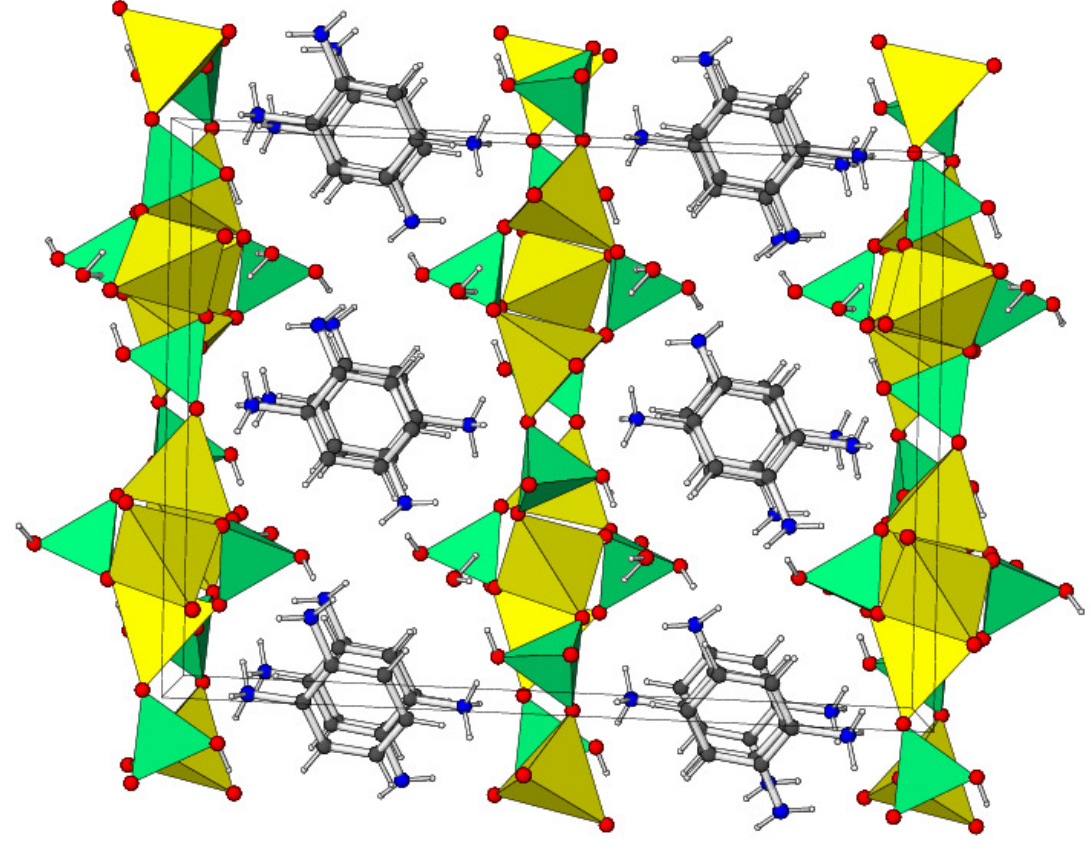
HPO moieties as yellow and green tetrahedra, respectively. Atom colors: O red; N blue; 4 C dark grey; H